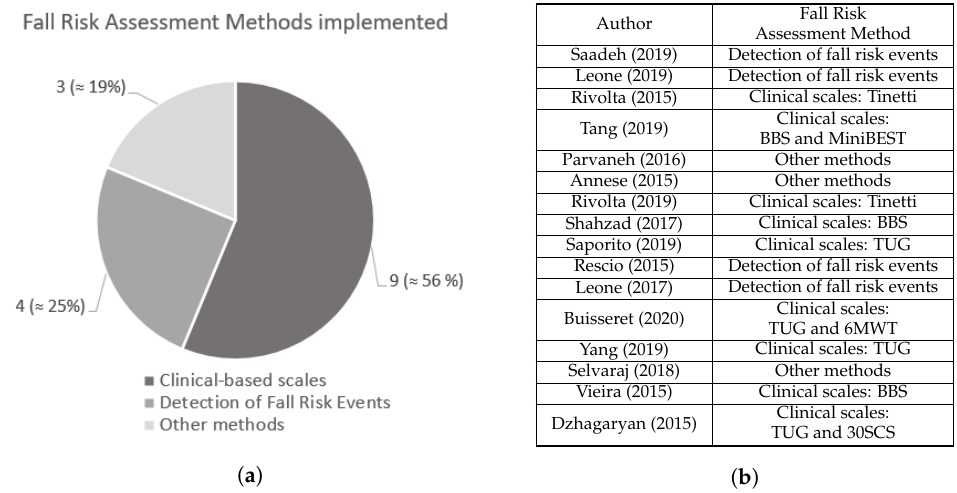
Figure 2. ( a ) Number of studies from each fall risk assessment methods identified. ( b ) Fall